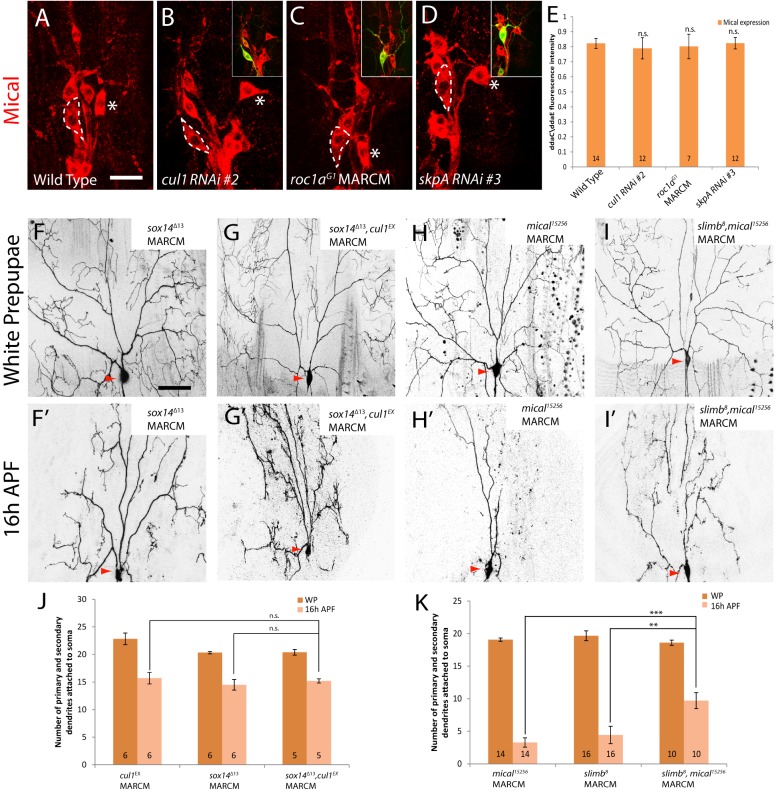
The Cul1-based SCF E3 ligase complex governs ddaC dendrite pruning in a Mical-independent pathway.(A–D) Confocal images show Mical stainings (in red) in various genotypes of ddaC neurons expressing UAS-mCD8-GFP driven by ppk-Gal4 at WP. ddaC somas are marked by dashed lines, and ddaE by asterisks. The Mical expression in ddaC neurons of wild type (A), cul1 RNAi (B), roc1aG1 MARCM (C), and skpA RNAi (D) remained largely unchanged. (E) Quantification of immunostaining for Mical was performed as described in Materials and Methods. The graph displays the average values of ddaC/ddaE ratios and S.E.M—n.s., not significant. n is shown on the bars. (E) The scale bar in (A) is 20 µm. (F–I′) Live confocal images of ddaC neurons expressing UAS-mCD8-GFP driven at WP and 16 h APF. (F and G) Although WP morphology remained largely unchanged, MARCM ddaC clones of cul1EX and sox14Δ13 double mutant exhibited dendrite pruning defects with an average of 15.2 primary and secondary dendrites attached (G′), similar to either cul1EX (Figure 1E′) and sox14Δ13 (F′) single mutant. (H and I) Although WP morphology remained unchanged, MARCM ddaC clones of mical15256, slimb8 double mutants exhibited a significant enhancement of ddaC dendrite pruning defects (I′), compared to either slimb8 (Figure 3E′) or mical15256 (H′) single mutants. (J and K) Quantification of the average number of primary and secondary dendrites attached to the soma of mutant ddaC neurons at 16 h APF. The number of samples (n) in each group is shown on the bars. **p<0.01, ***p<0.001, n.s., not significant. Error bars represent S.E.M. Dorsal is up in all images. The scale bar in (F) is 50 µm. See genotypes in Text S1.